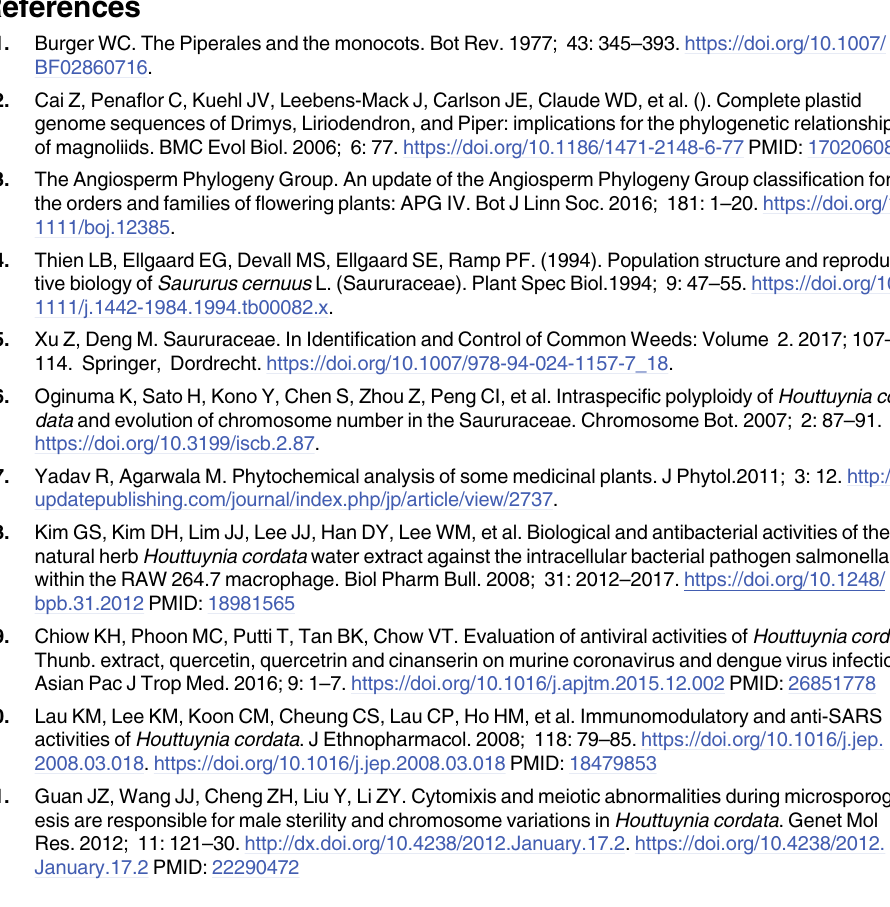
S5 Table. Synonymous (Ks) and non synonymous (Ks) substitution rate of homologous coding genes between H . cordata and other four closed related